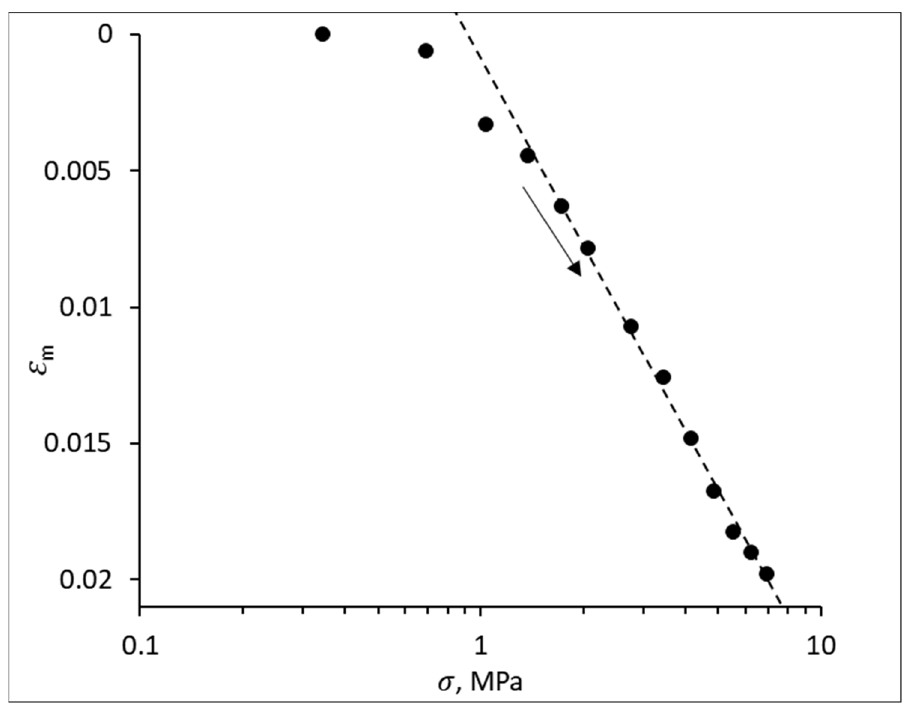
Figure 4. Strain–stress path of coal sample 3 under monotonic stress increase (up to 6.9 MPa or 1000 psi).